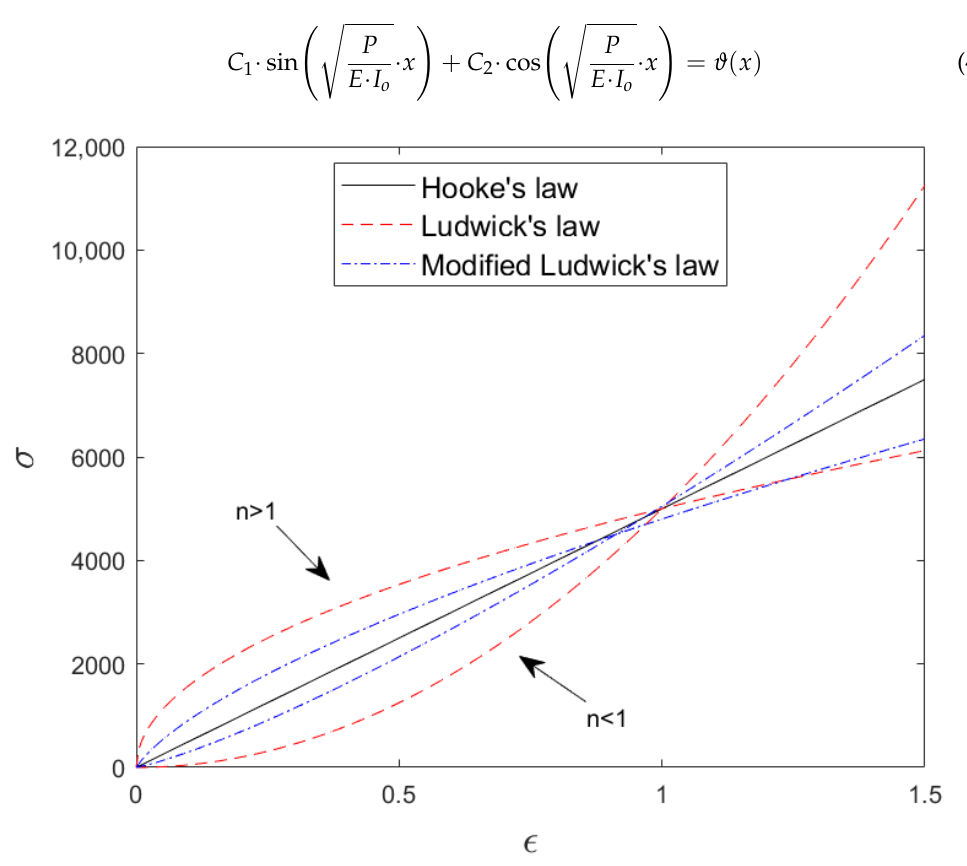
Figure 1. Stress–strain diagram of typical Hooke’s law, Ludwick Constitutive law, and modified Figure 1. Stress –strain diagram of typical Hooke’s law, Ludwick Constitutive law, and modified Ludwick Ludwick law.